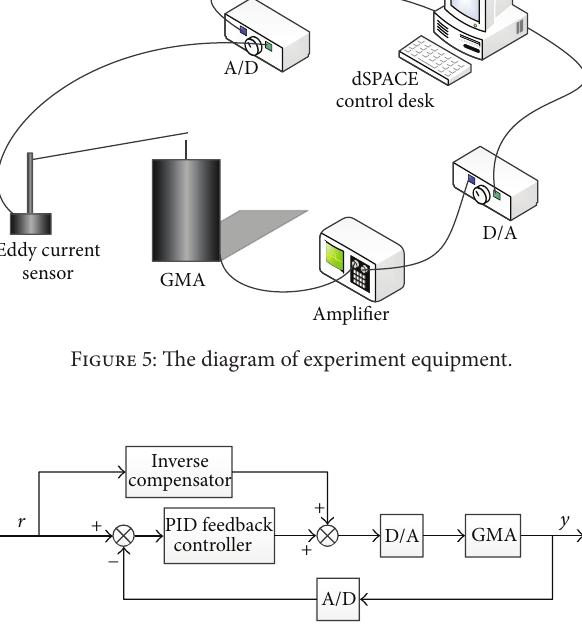
Figure 6: The diagram of the combined control scheme.